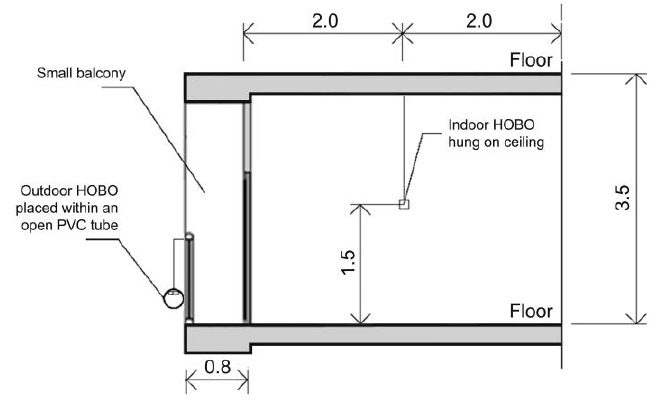
Fig. 8. Section of the B apartment unit.